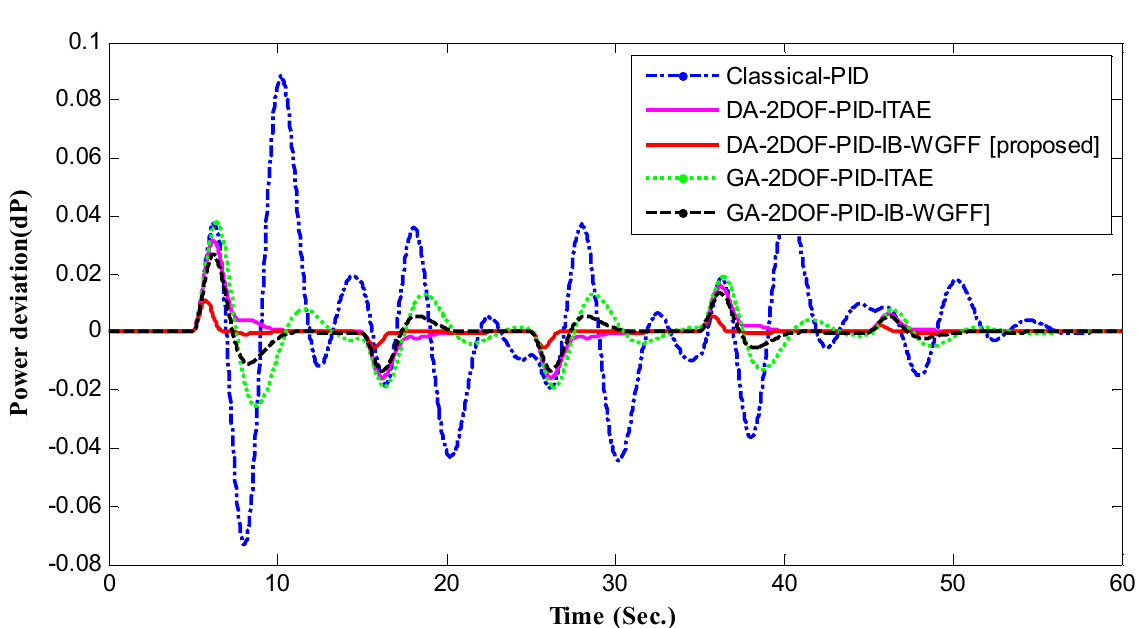
Figure 36. Δf (cid:2870) for Area 2 under load disturbances.